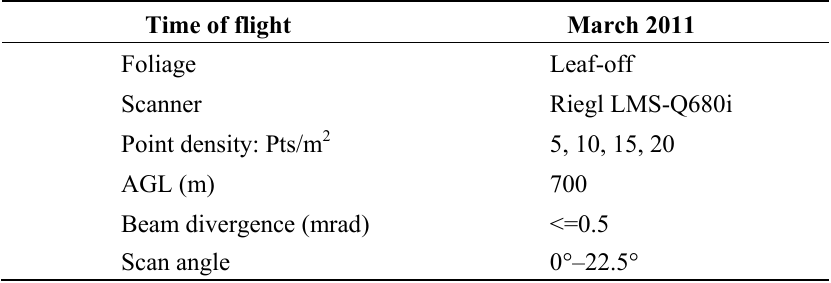
Table 4. Configurations of the airborne LiDAR campaign in Test Site II.